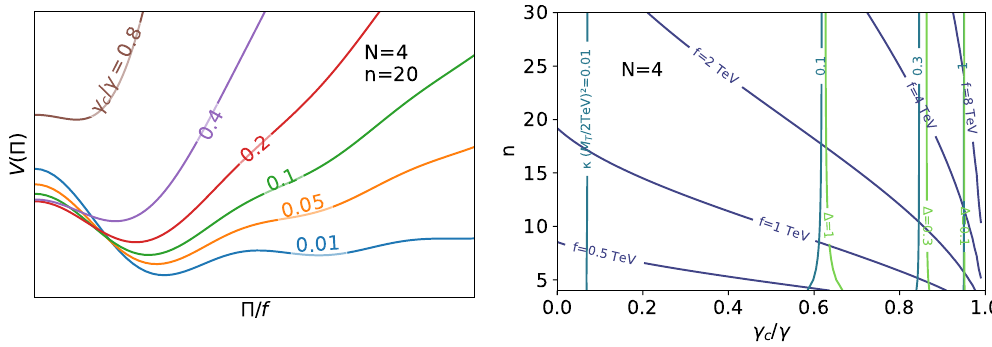
Figure 3 . ( Left ) Shape of the Gegenbauer-Higgs potential of eq. (3.6) for N = 4 , n = 20 and different values of γ c /γ . The global minimum approaches the origin as γ tends to its critical value while, for small γ c /γ , its location is determined by the Gegenbauer contribution to the potential. ( Right ) Parameter space of the Gegenbauer-Higgs model. Values of the log-derivative f/v tuning are shown as ∆ contours, while κ quantifies the tuning of top-sector contributions to the Higgs mass. The two tunings evolve in opposite ways as functions of γ c /γ and both admit values above 10% in the 0 . 6 – 0 . 95 region for top-partner masses of about 2